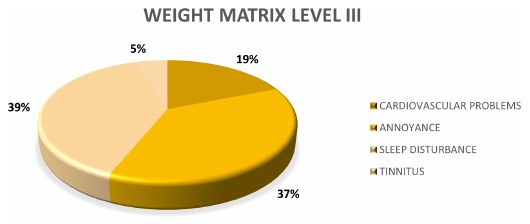
Figure 5: Level III weights (nighttime health)